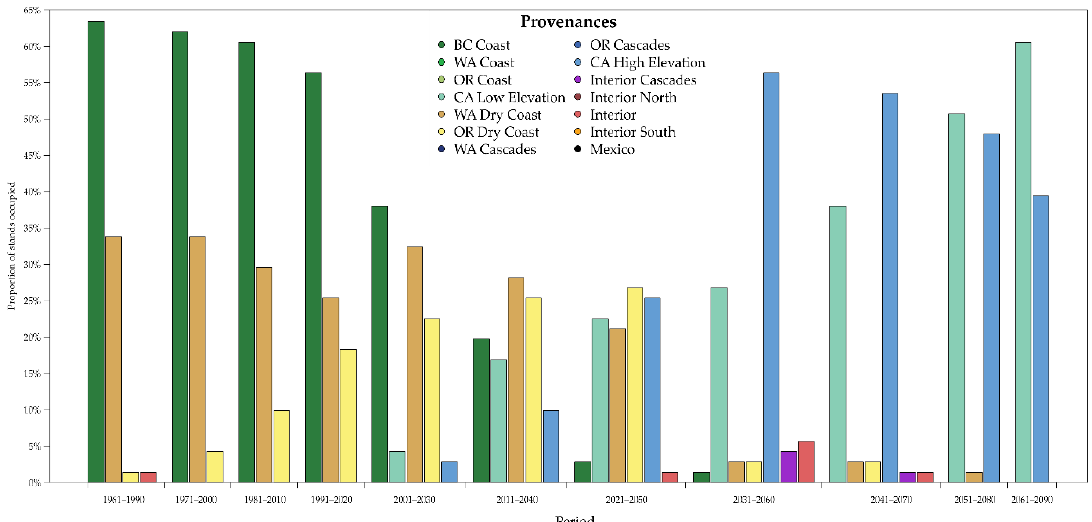
Figure 4. Predicted climate change effect on the proportion of Douglas-fir provenances potentially suitable in Italy in the future across the stands where this species has been detected and measured at the current time.